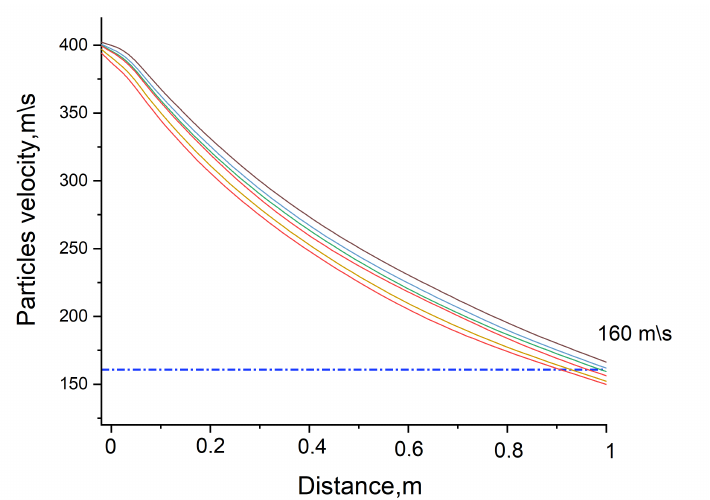
Figure 7. Change in the velocity of UHMWPE particles along the flame’s central axis at a pressure of 1